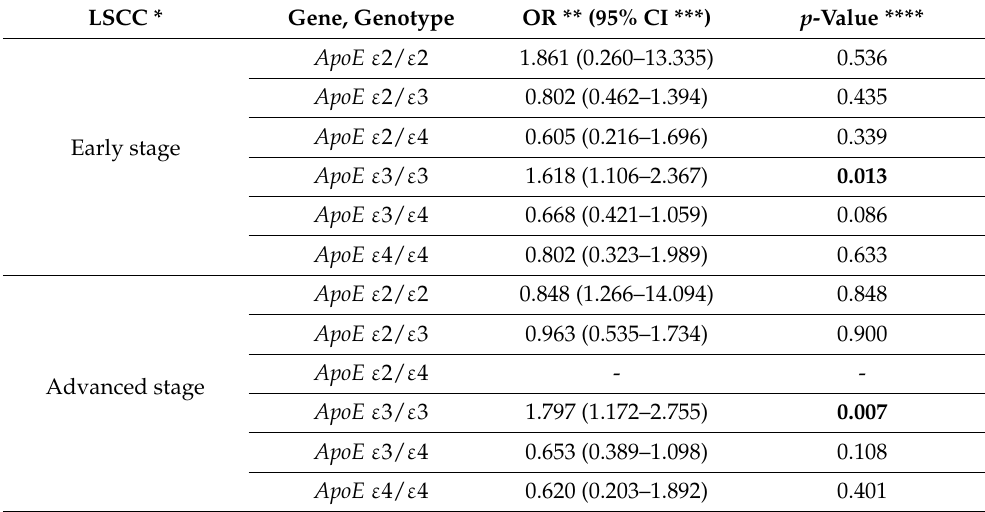
Table 5. Binary logistic regression analysis of ApoE in the control group and early and advanced LSCC stage